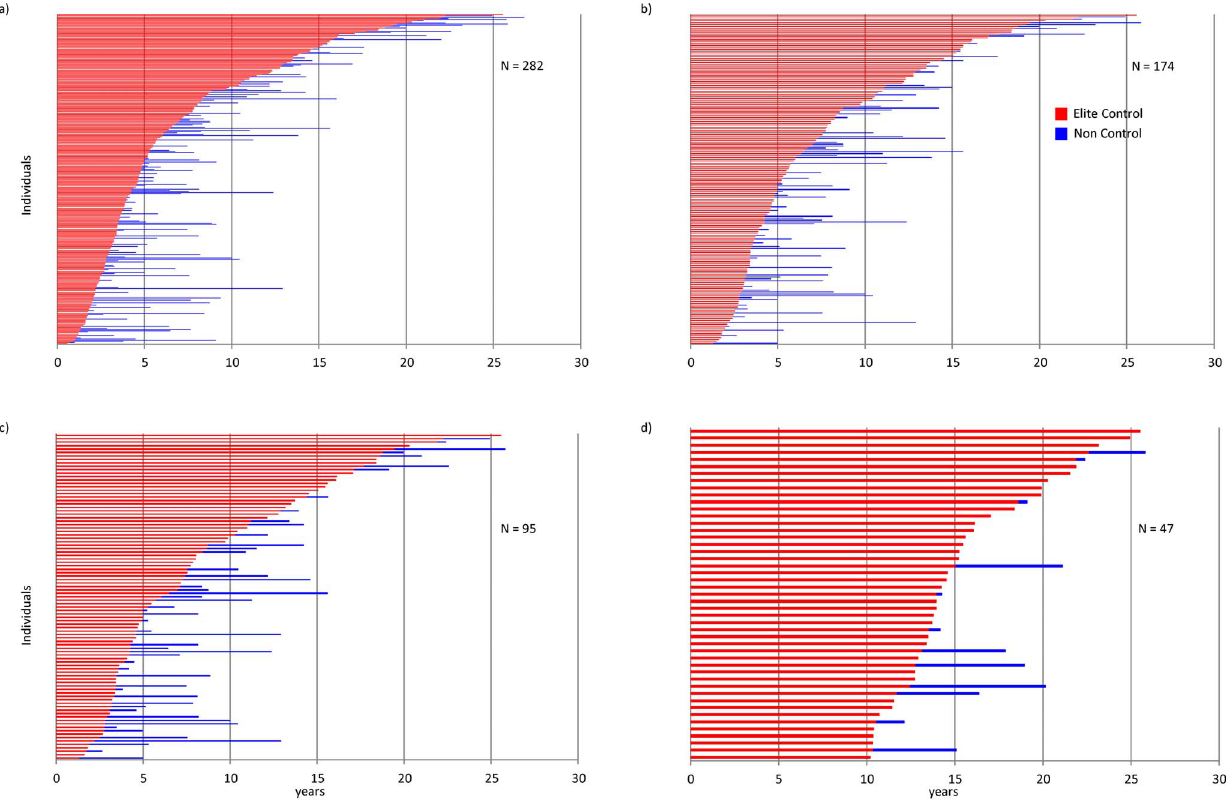
Figure 1. Total ART-naı¨ve follow-up time spent as an elite controller for 4 of the best performing definitions: a) A , b) E , c) F ,and d) J using the CSCADE dataset. A: HIV-positive $ 6 months, with $ 2 consecutive HIV-RNA , 75 copies/ml; E: HIV- positive $ 1 year, with $ 3 consecutive HIV-RNA , 75 copies/ml spanning $ 12 months F: HIV- positive $ 1 year, with $ 3 consecutive HIV-RNA , 75 copies/ml spanning $ 12 months with no previous blips $ 1000 copies/ml, J: HIV- positive $ 10 years, with $ 90% of HIV-RNA ( $ 2 HIV-RNA ever) , 400 copies/ml.